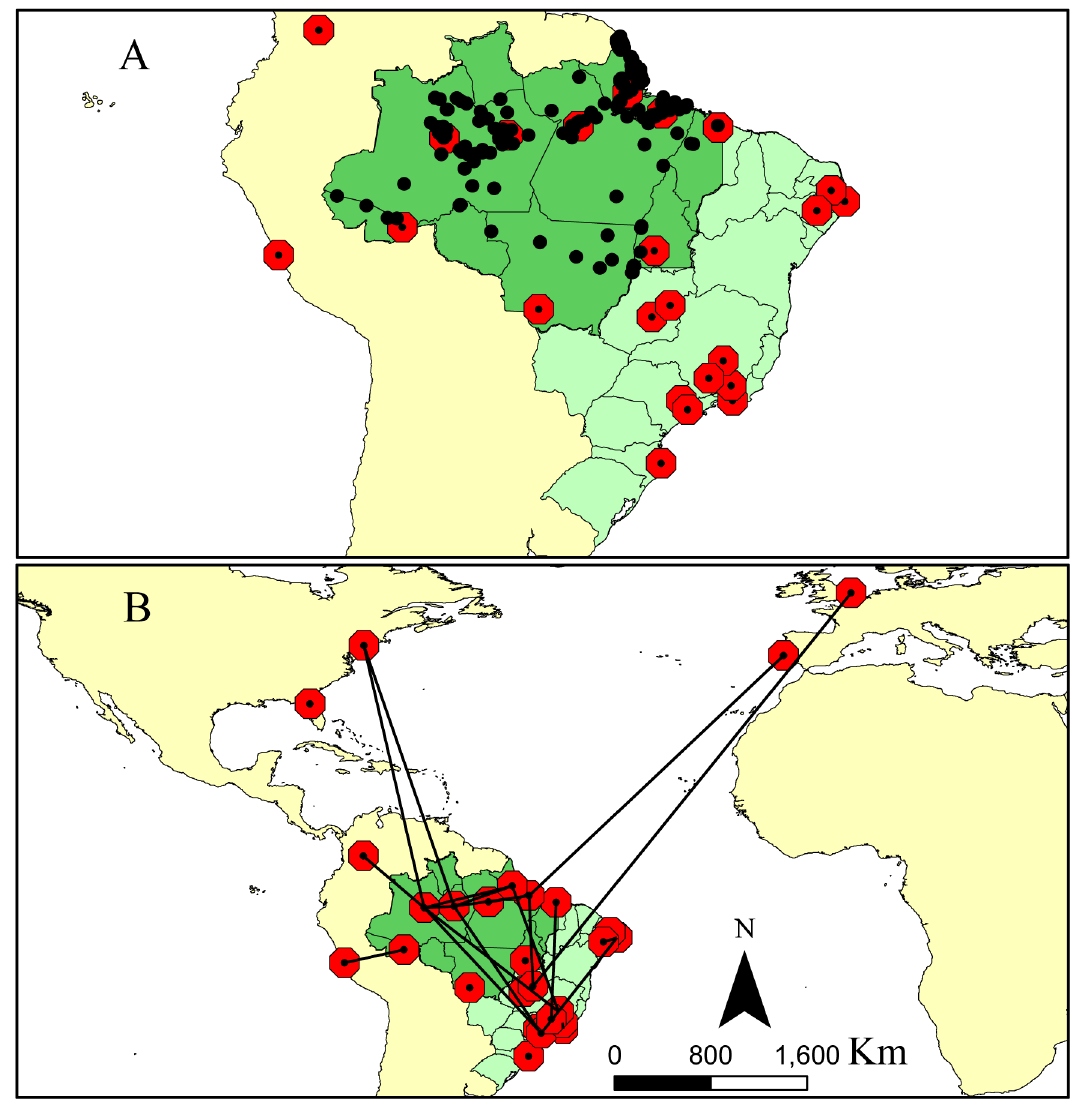
Fig 3. Locations of study regions in the Legal Brazilian Amazon. (A) Geographical distribution of studies with aquatic vertebrate species (black dots) and locations of research institutes (red circles with black dots) in South America; (B) Locations of national and international research institutes that performed the studies (red circles with black dots) and network collaborations among them (black lines).